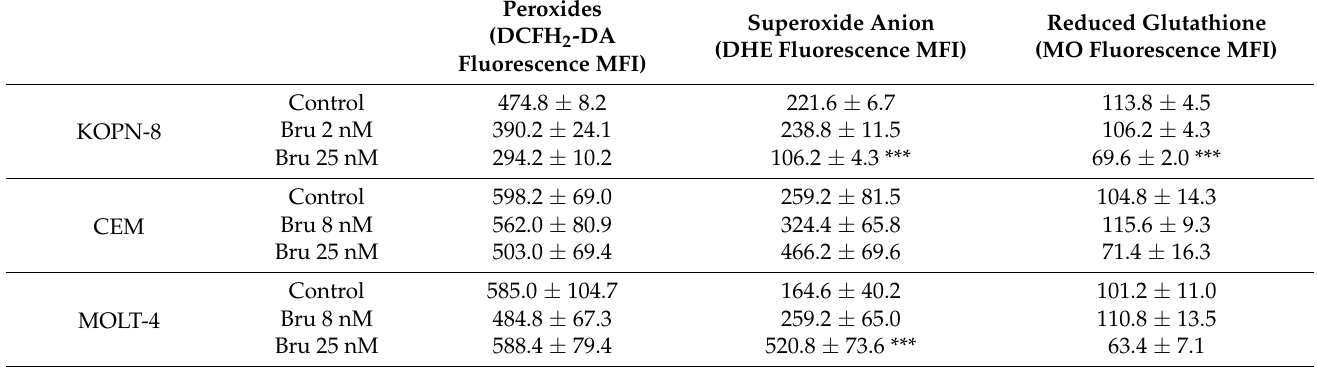
Table 2. Oxidative stress parameters induced by brusatol in acute lymphoblastic leukemia cell lines.